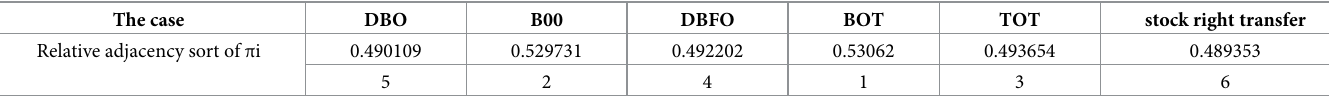
Table 5. Relative progress of each mode of operation π i . The case